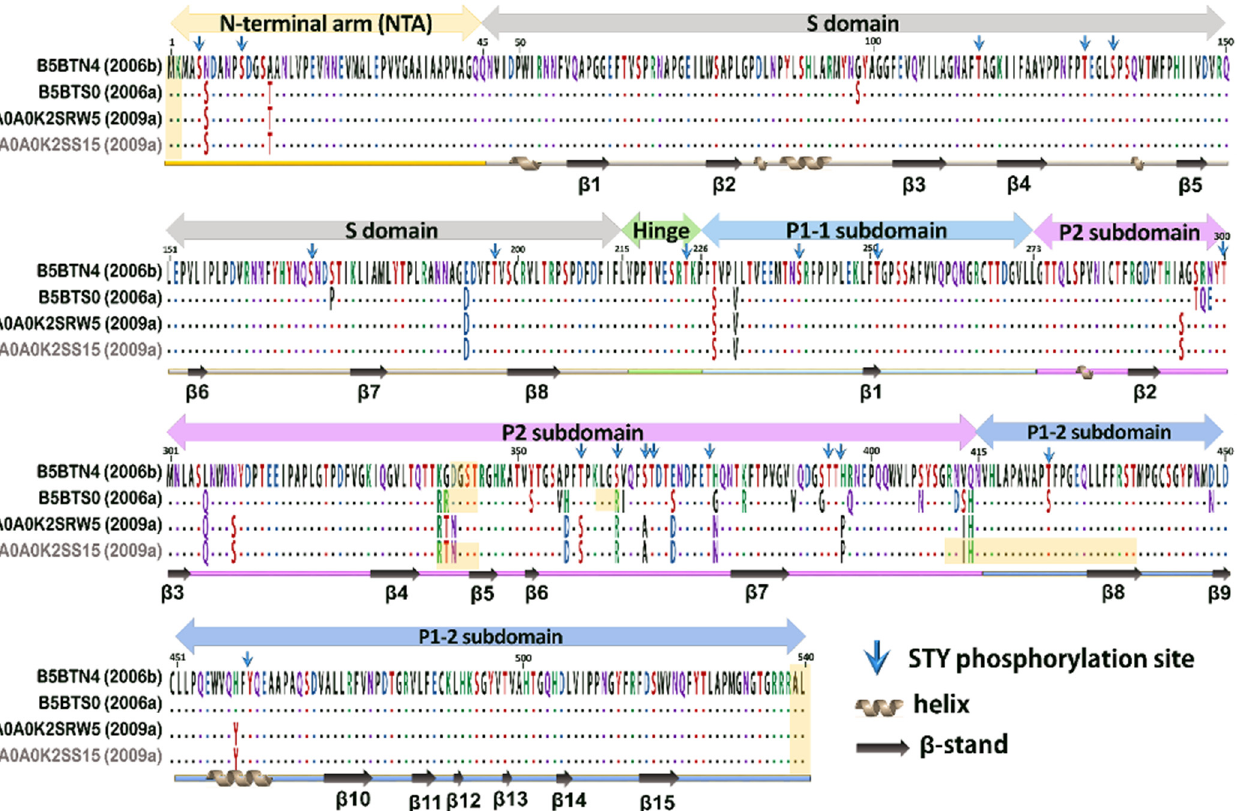
Figure 2. The best-identified norovirus strains. The best-identified strains of variants 2006b and 2006a were B4BTN4 and B5BTS0, respectively. Although the best-identified strain of variant 2009a (A0A0K2SRW5) was A0A0K2SS15, they were identical in amino acid sequence. The virus strains for VLPs were shown in black accession numbers; the best-matched variant 2009a was indicated in the grey accession number. Dots represented amino acids identical to the top sequence- B5BTN4; missing residues were shadowed. The secondary structure of VP1 was noted under the aligned sequences.